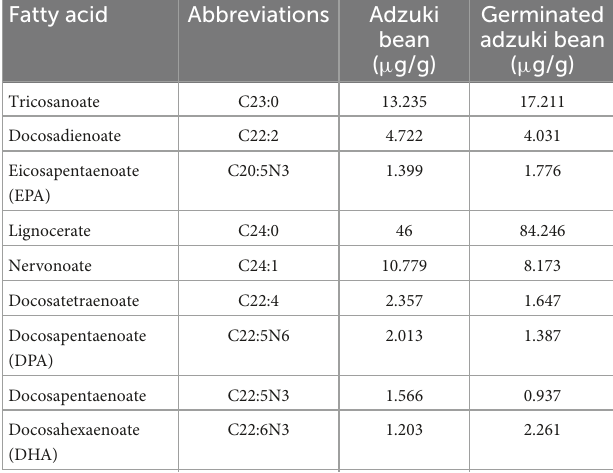
TABLE 3 Fatty acid composition of adzuki bean before and after germination.